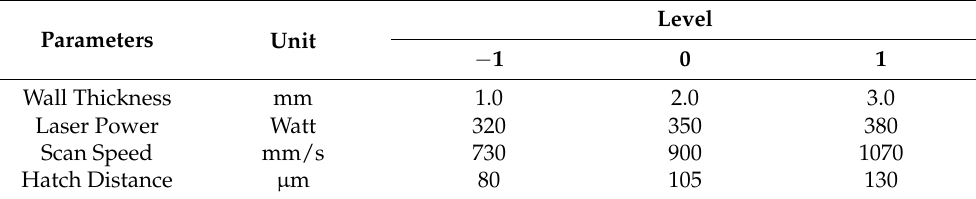
Table 2. Process parameters and their levels for DOE.